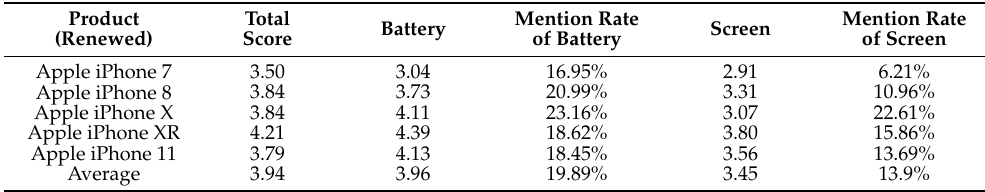
Table A3. Fine-grained sentiment analysis of